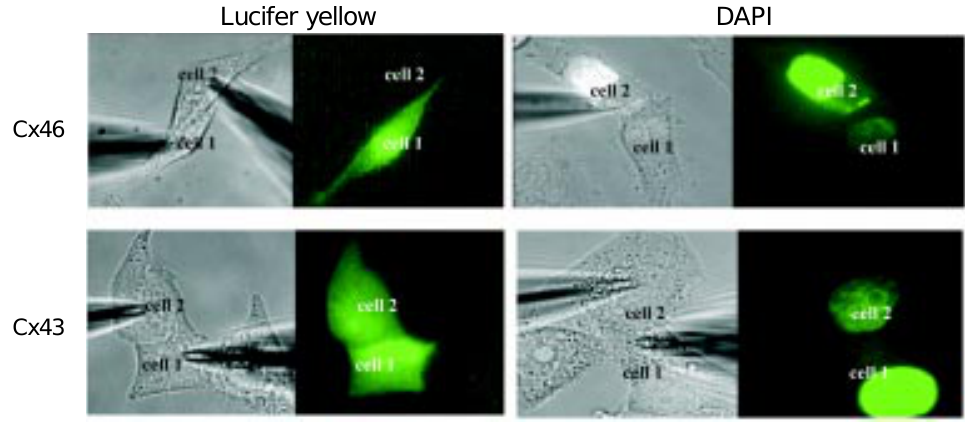
cation selective. Neuro-2a cell pairs transfected with Cx46 show transfer of DAPI, a posi- tively charged dye, but not Luci- fer yellow, a negatively charged dye. Cx43-transfected cell pairs readily transfer both DAPI and Lucifer yellow. Junctional con- ductance exceeded 20 nS in all cell